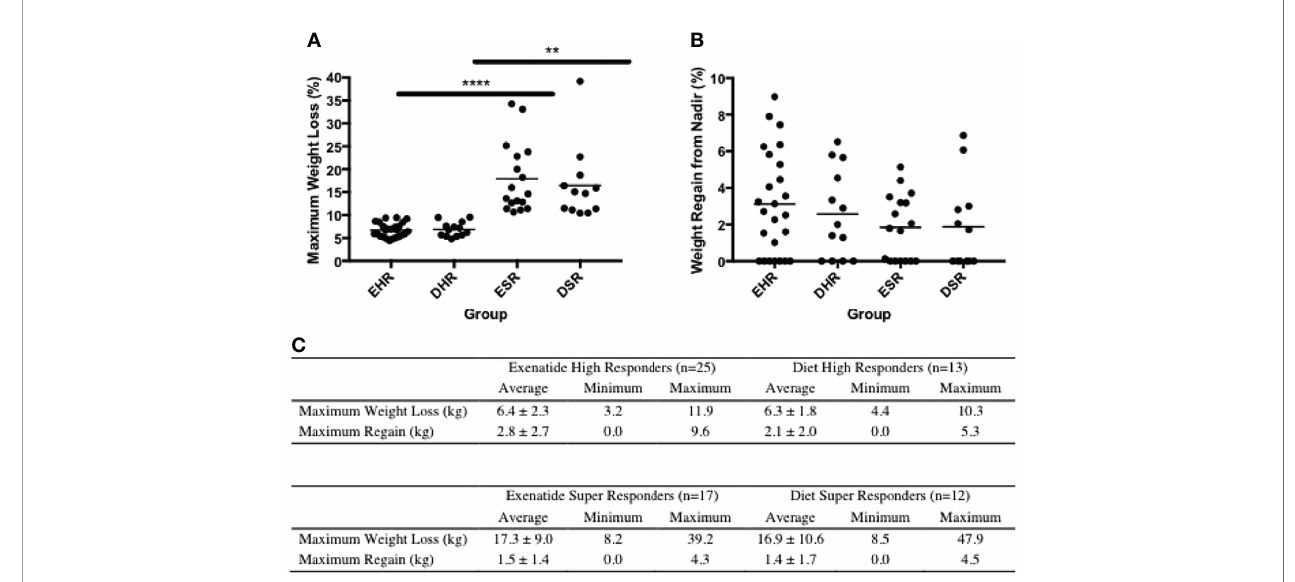
FIGURE 3 | (A) Maximum weight loss (%) among high responders and super responders in both treatment groups **** = p < 0.0005, ** = p < 0.005 (B) Percentage weight regain from lowest weight achieved among high responders and super responders in both treatment groups. (C) Maximum weight loss and regain from lowest weight achieved in exenatide and diet high responder and super responder groups. Values are mean +/- SD. EHR, exenatide high responder; ESR, exenatide super responder; DHR, diet high responder; DSR, diet super